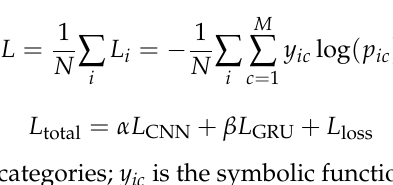
specific network layers are shown in Table 1, where Conv-BN denotes the convolution layer and batch normalization layer, and FC is the fully connected layer. The input of the CNN branch is the vibrational signal matrix with the size of 6×32×32. The network uses the convolution kernel with the size of 3×3 to extract features. The padding type of the convolution kernel is “SAME”. Then, the kernel is normalized by the BN layer with a Relu activation function. The CNN branch recalibrates the original features by channel atten- tion and position attention. The spatial resolution of the feature map at each stage becomes half that of the previous stage, and the number of channels becomes twice that of the pre- vious stage. The network obtains a feature map with the size of 128×8×8 by three stages of feature extraction. The captured features are then fed into the fully connected layer with 1024 neurons. The input of the GRU branch is the original vibration signal with 1024 sam- pling points. The network obtains the temporal features through the 2-layer GRU atten- tion unit, and the features are fed into the fully connected layer with 128 neurons. The fully connected layers of the CNN branch and GRU branch are concatenated, and the number of neurons is 1152. The network is nonlinearly adjusted by two fully connected layers. Finally, the diagnosis results of eight faults are output by the softmax function. Table 1. The STNet’s structure.